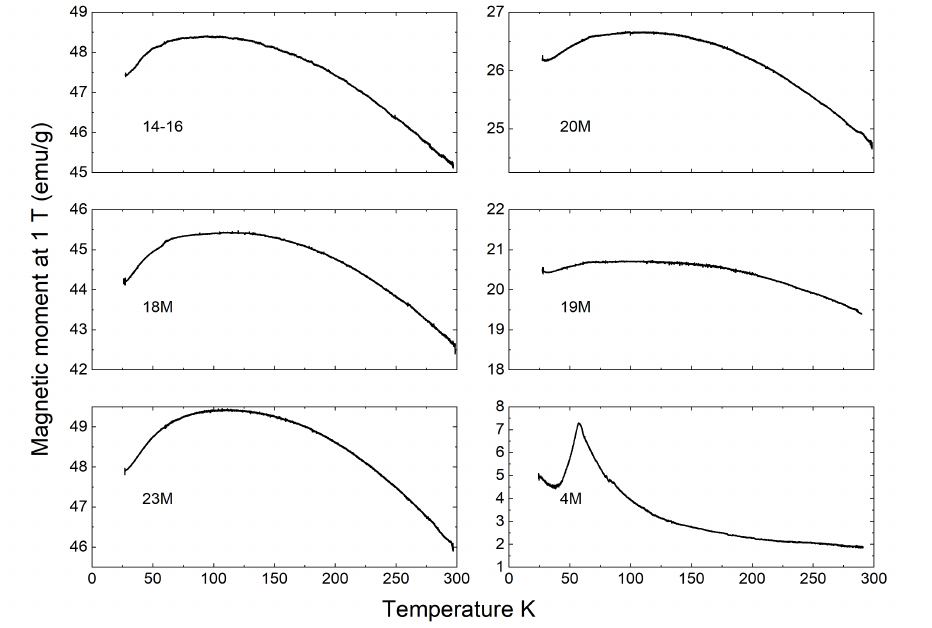
Figure 2. Temperature dependence of the magnetic moment at 1 T obtained with Vibrating Sample Magnetometry (VSM) measurement for all samples as per Table 1. Please note the variation in the scale of the vertical